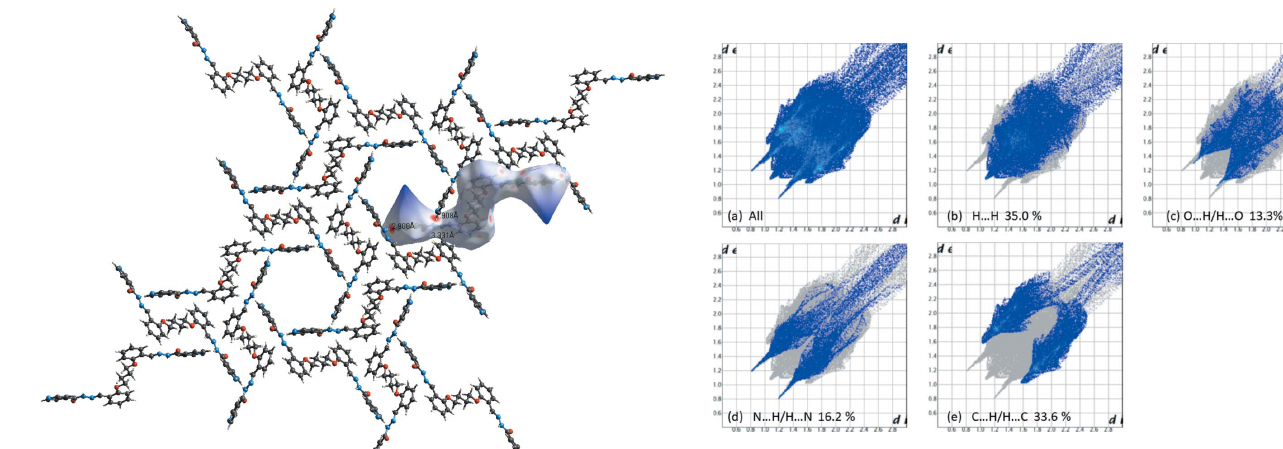
Figure 8 A view of the Hirshfeld surface mapped over d norm of compound (II), showing the various intermolecular contacts in the crystal.